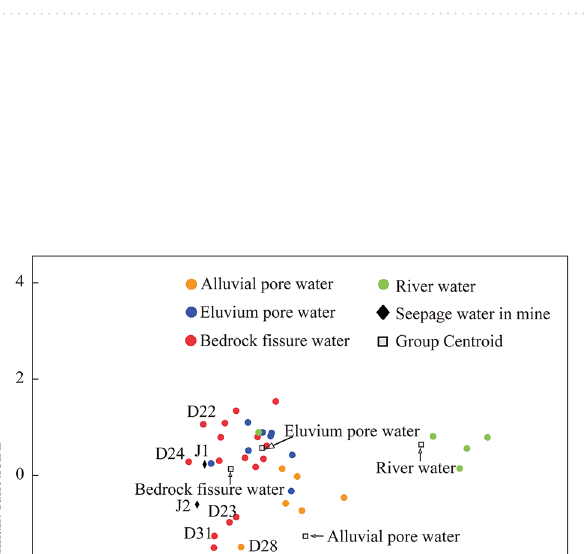
Table 3. Misjudgement analysis of training samples and seepage water source identification results.